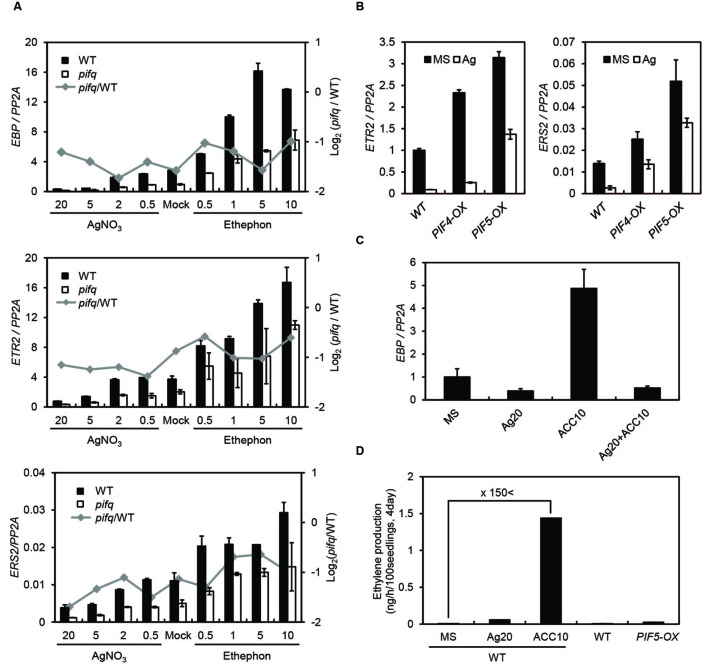
Phytochrome-interacting factors promote ethylene marker gene expression independent of ethylene. (A) Expression of the representative ethylene markers EBP, ETR2, and ERS2 in 4-day-old WT and pifq mutant etiolated seedlings. Seedlings were untreated (mock) or treated with AgNO3 or ethephon at the indicated concentrations (μM). The gray line indicates log2 fold changes between pifq mutants and WT. (B) Expression of the representative ethylene markers ETR2 and ERS2 in 4-day-old WT, PIF4-OX, and PIF5-OX etiolated seedlings untreated (mock) or treated with AgNO3 (20 μM). (C) Expression levels of EBP from 4-day-old WT etiolated seedlings untreated (mock) or treated with AgNO3 (20 μM), ACC (10 μM), or AgNO3+ACC. PP2A was used as an internal qPCR control (SD, n = 3 biological replicates). (D) Quantification of endogenous ethylene from 4-day-old WT and PIF5-OX seedlings treated as indicated (SD, n = 2 biological replicates).